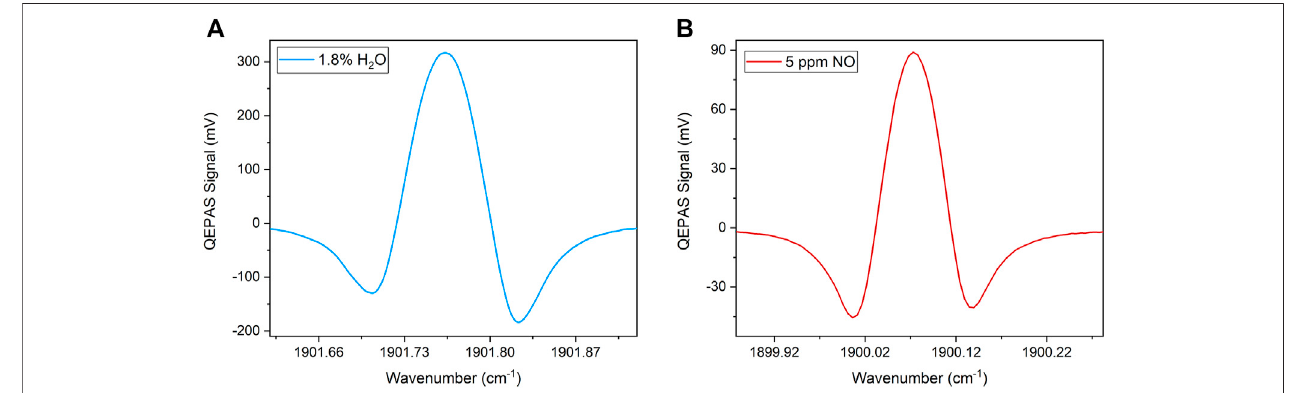
FIGURE 8 | QEPAS peak signals as a function of the NO concentration (red diamonds) and the corresponding best linear fi t (red dotted line).